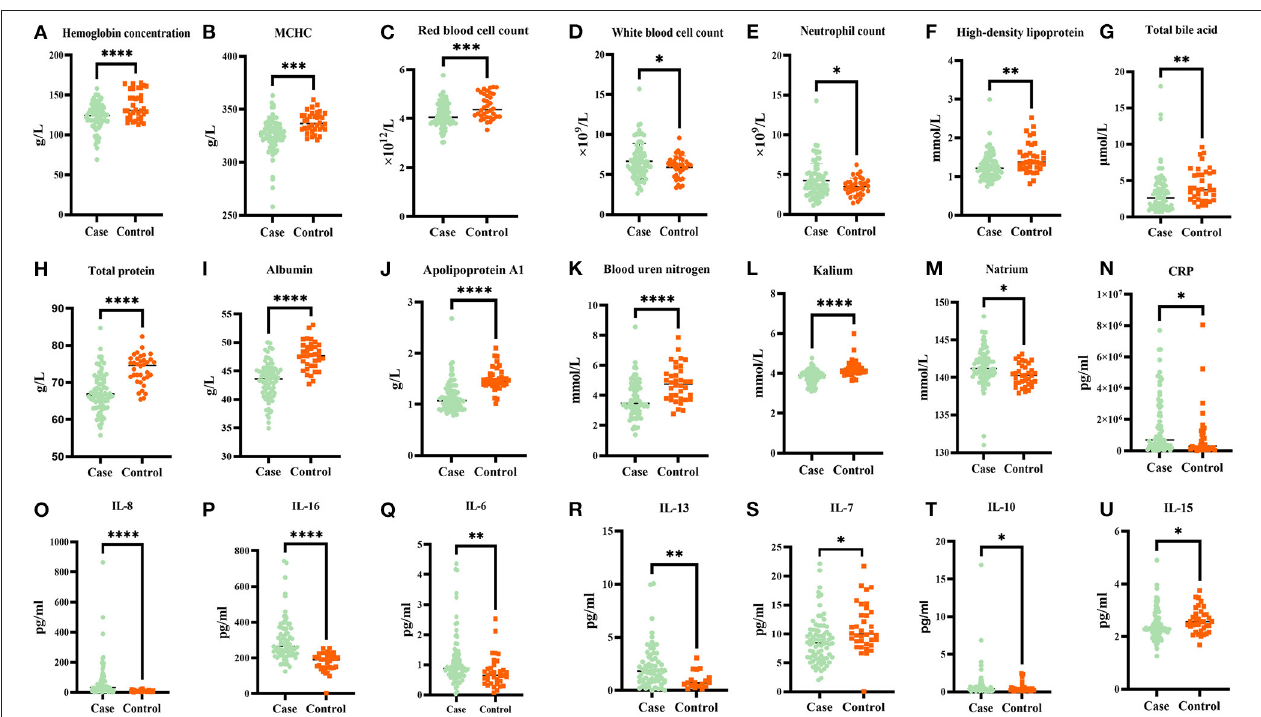
FIGURE 1 | Comparison of blood routine, biochemical factors, and inflammation cytokines concentrations in first episode drug naive patients with schizophrenia and healthy controls. Hemoglobin concentration, mean corpuscular hemoglobin concentration (MCHC), red blood cell count, high-density lipoprotein, total bile acid, total protein, albumin, apolipoprotein A1, blood urea nitrogen, kalium, and IL-7 were lower in the case group than in healthy controls [ (A–C,F–L,S) p < 0.05, respectively]. While white blood cell count, neutrophil count and natrium, CRP, IL-8, IL-16, IL-6, IL-13, IL-10, and IL-15 were higher in case group than in healthy controls [ (D,E,M–R,T,U) p < 0.05, respectively]. The false discovery rate (FDR) method is used to adjust the p -value. * p ≤ 0.05, ** p ≤ 0.01, *** p ≤ 0.001, **** p ≤